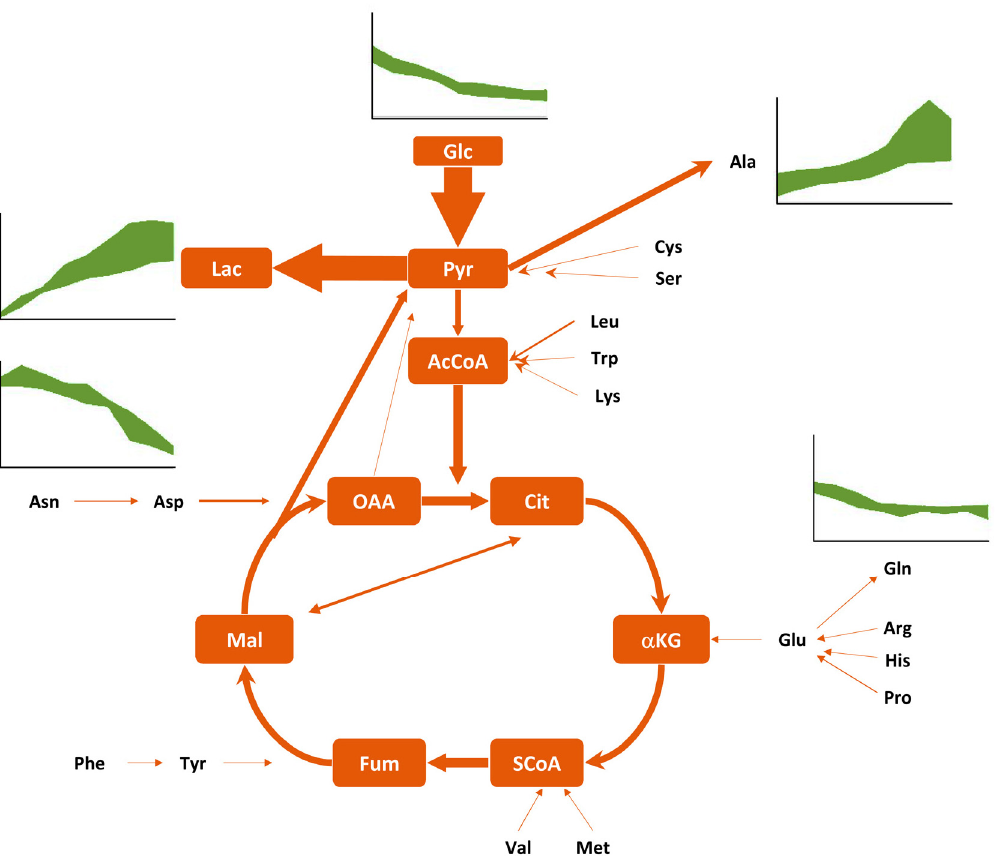
Figure 3. Schematic flux distribution of the central metabolism of CR.pIX cells, including glycolysis, citric acid cycle and amino acid catabolism. Selected concentration profiles of extracellular metabolites indicate uptake and release of main metabolites (data bands include several experiments). Intracellular fluxes are depicted with arrow with sizes corresponding to the rate of the illustrated reaction. Glucose (Glc), lactate (Lac) and glutamine (Gln) were determined with a Bioprofile 100 Plus (Nova Biomedical, Waltham, MA, USA), extracellular amino acid concentrations were determined by